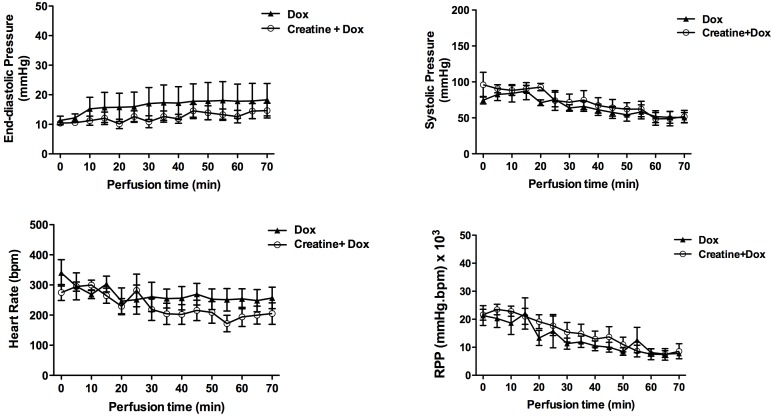
Effect of exogenous creatine supplementation (500 µmol/L) on cardiac function during 70 min doxorubicin (Dox) exposure (n = 8, C57BL/6J; male).RPP- rate pressure product. Data mean±S.E.M.